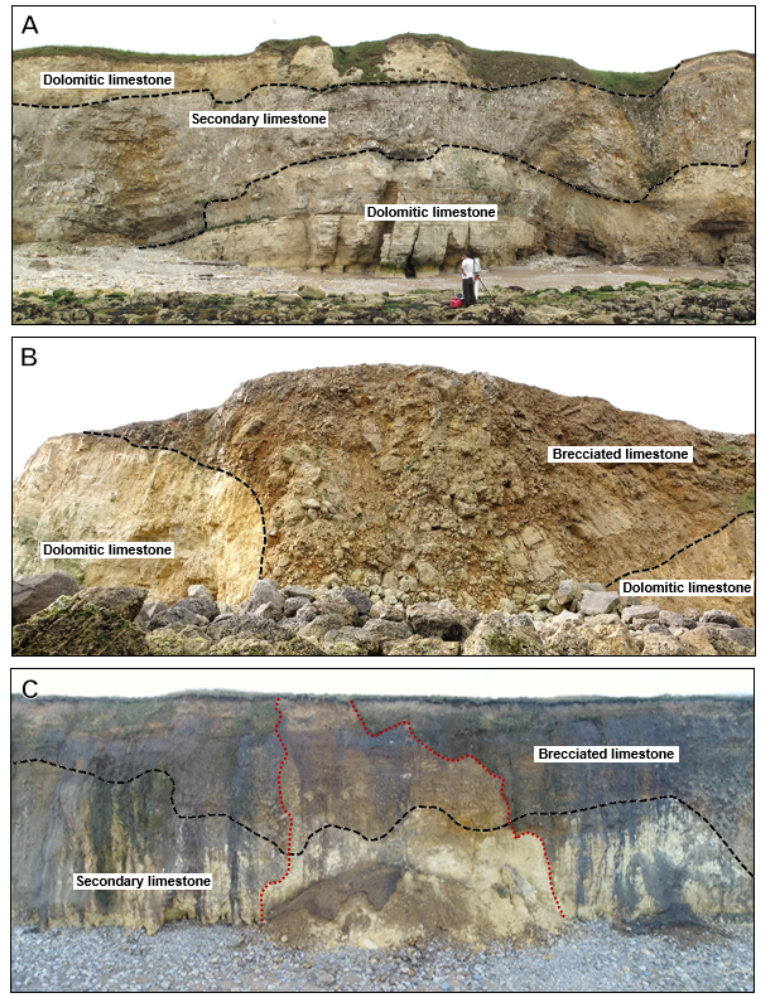
Figure 2. Field photographs showing the three main cliff lithologies, and large-scale failure. ( A ): Dolomitic and secondary limestones. ( B ): Dolomitic and brecciated limestones. ( C ): Erosion of the entire cliff face (volume ~ 175 m 3 ), affecting a section immediately outside of our survey area, and which occurred within 6 months of the end of our monitoring period. The cliff is 20–25 m high in all